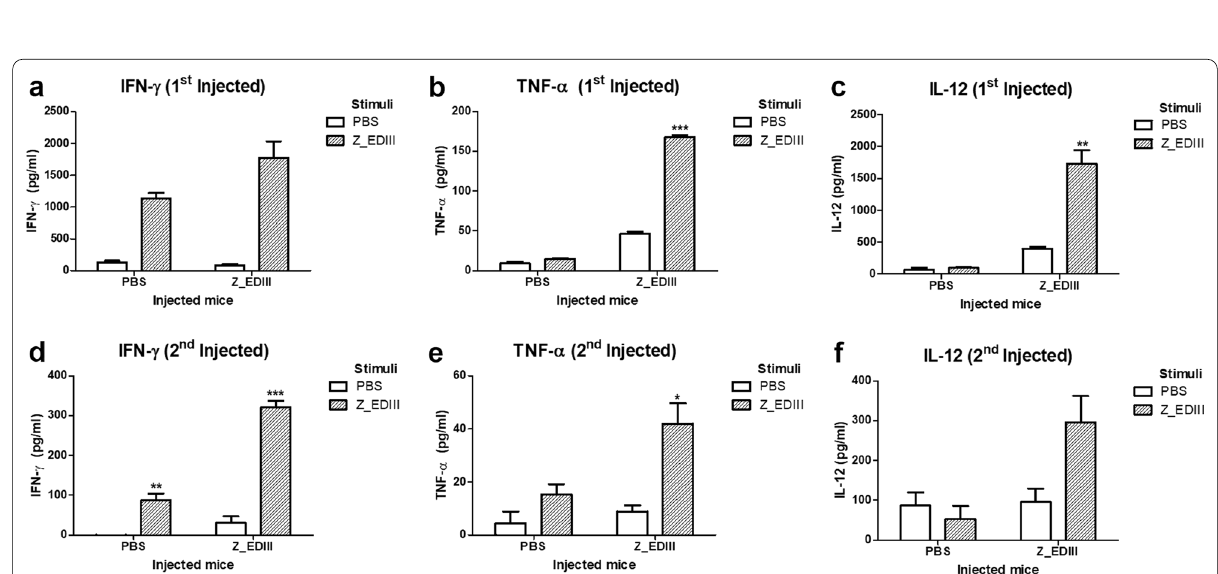
Fig. 5 Cytokine production elicited by Z_EDIII immunization. C57BL/6 mice ( n euthanized at 7 and 17 dpi (7 dpi; a – c , 17 dpi; d – f ). Splenocytes were pooled from five mice in each group and stimulated with Z_EDIII (10 μg/ ml) or PBS for 48 h. Concentrations of IFN‑γ, TNF‑α and IL‑12 from the supernatant by ELISA. Data show the mean sample was assayed in triplicates. Statistical analysis * p < 0.05, ** p < 0.01, *** p <